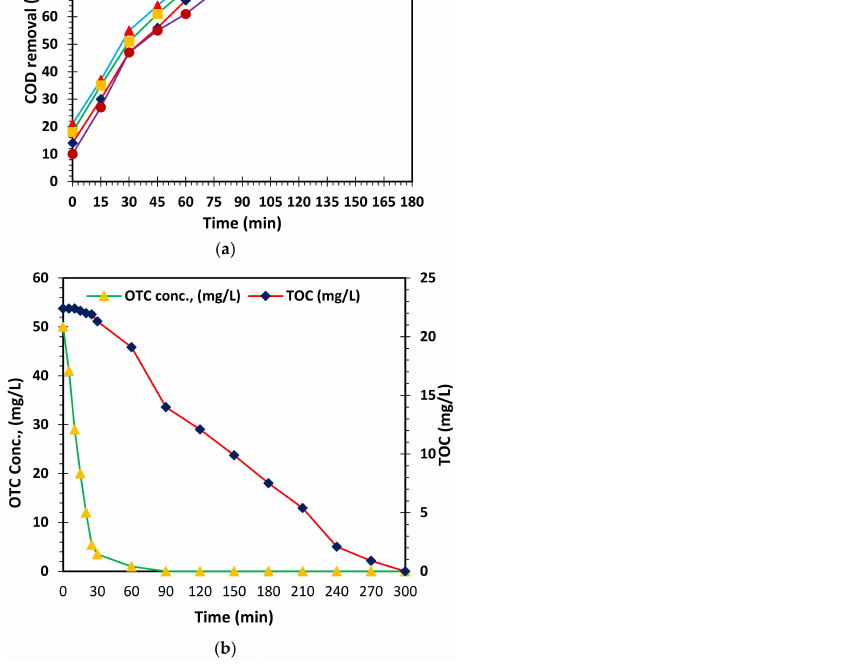
Figure 12. ( a ) Reusability of the L-Histidine (2 wt.%)-TiO 2 catalyst for LEPW removal and ( b ) TOC removal of OTC